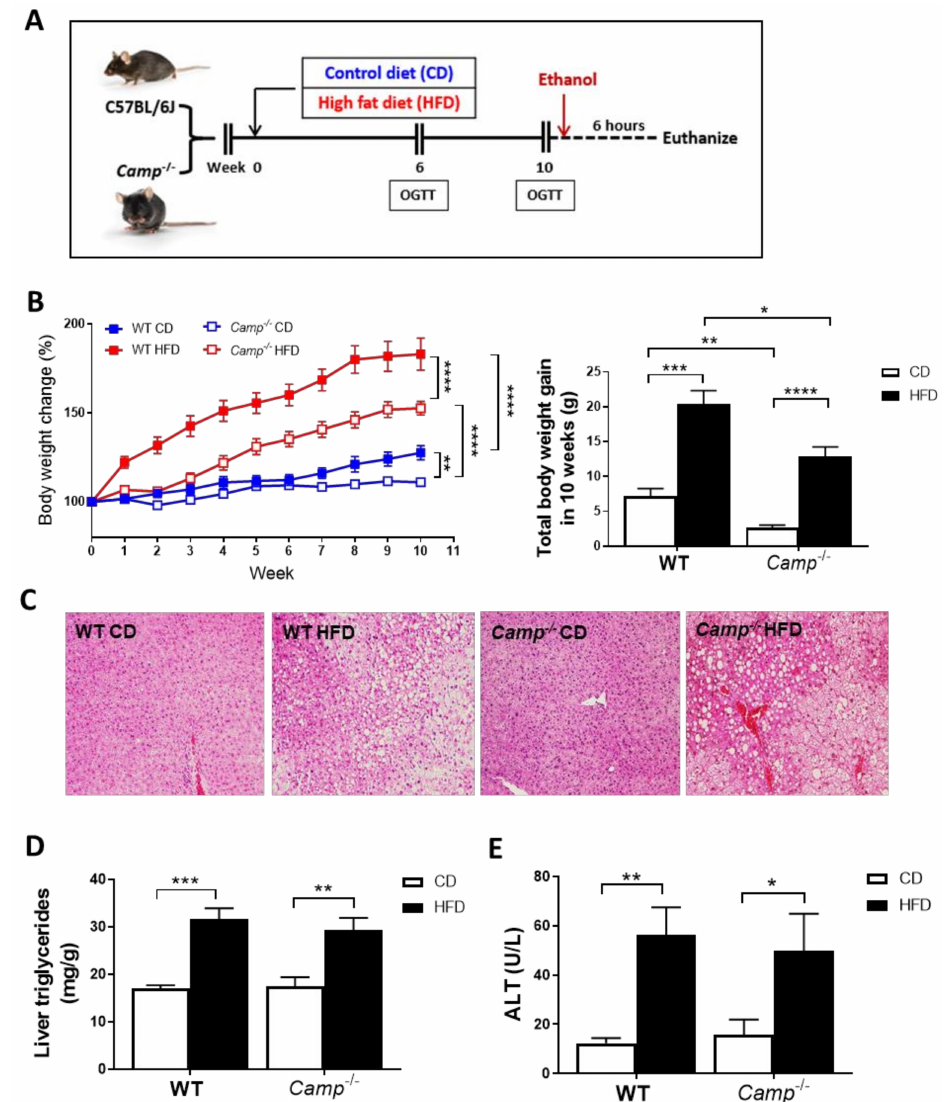
Figure 1. Feeding paradigm and the effects of Camp deletion on HFD-induced body weight gain, liver steatosis and injury. ( A ) Experimental design. ( B ) Body weight change of WT and Camp –/– mice with HFD feeding over 10 weeks (left panel). Total body weight gain in 10 weeks (right panel). ( C ) Representative images of H&E-stained liver tissues. Magnification: 100 × . ( D ) Liver triglyceride contents. ( E ) Serum ALT levels. CD: control diet; HFD: high-fat diet. Data are expressed in Mean ± SEM (n = 4–9 mice/group). * p ≤ 0.05, ** p ≤ 0.01, *** p ≤ 0.001, **** p ≤